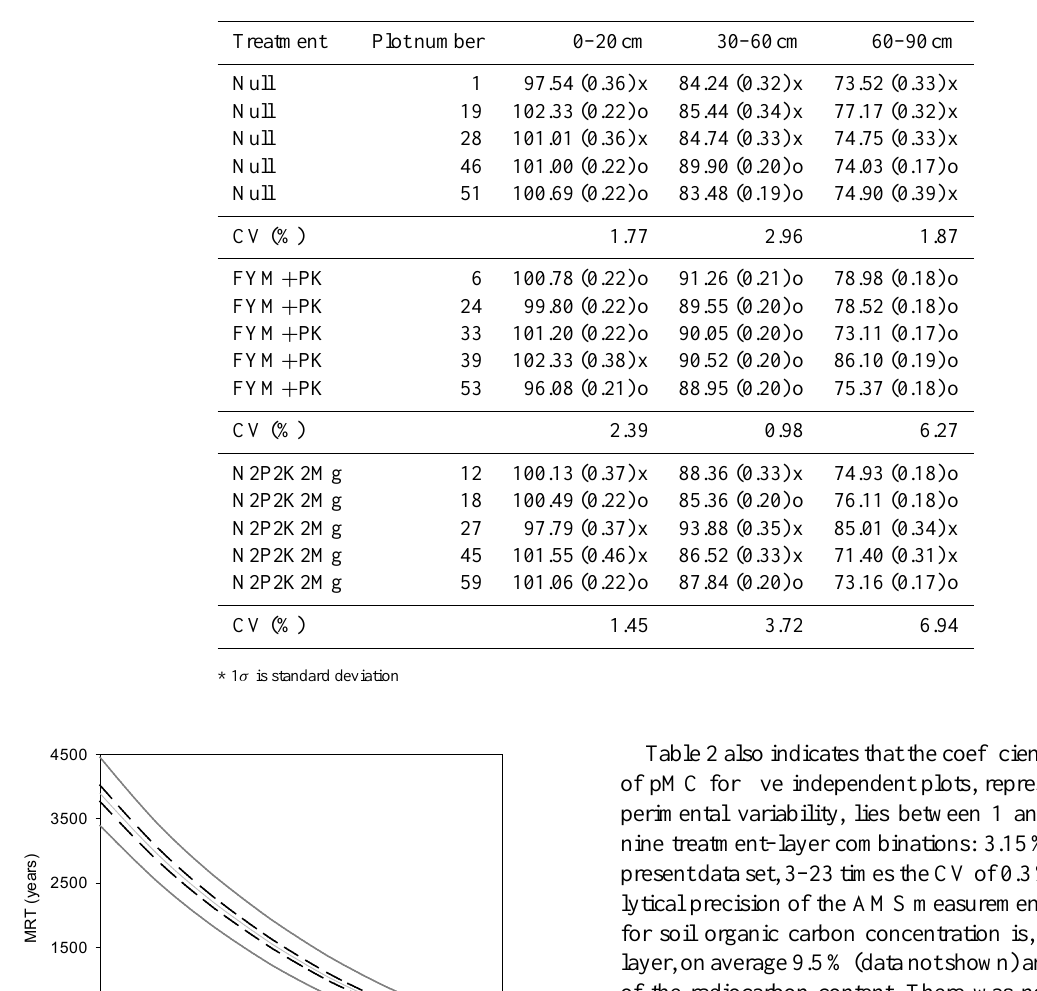
Table 2. Percent modern carbon (%) ( ± 1 σ uncertainty ∗ ) of organic carbon in soil samples from the ZOFE trial taken in 2012 for three treatments and three soil layers. “CV” lines indicate the coefficient of variation for each treatment–depth combination. Plot number according to Fig. 1. “x” refers to lab ETH and “o” refers to lab Bern.